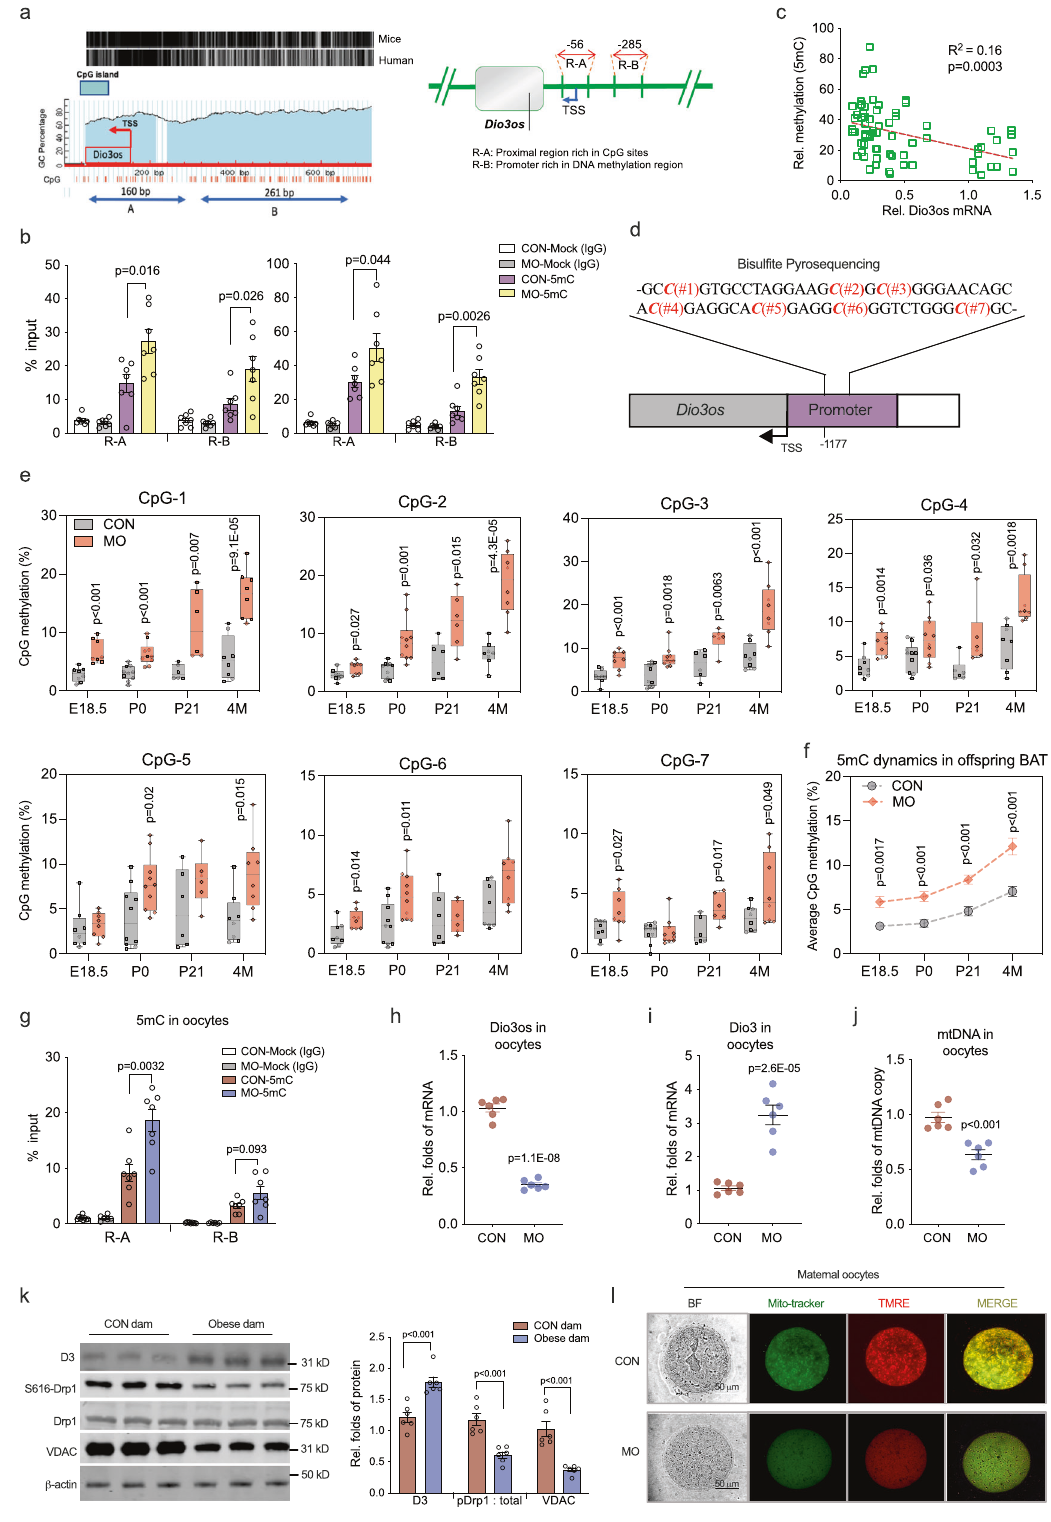
with the essential role of thyroid hormone for oocyte mito- chondrial biogenesis 44,45 , mitochondrial fi ssion protein Drp1- S616 and mitochondrial membrane protein VDAC were decreased in obese dam oocytes (Fig. 8k), which aligned with the reduced mitochondrial density and mitochondrial membrane